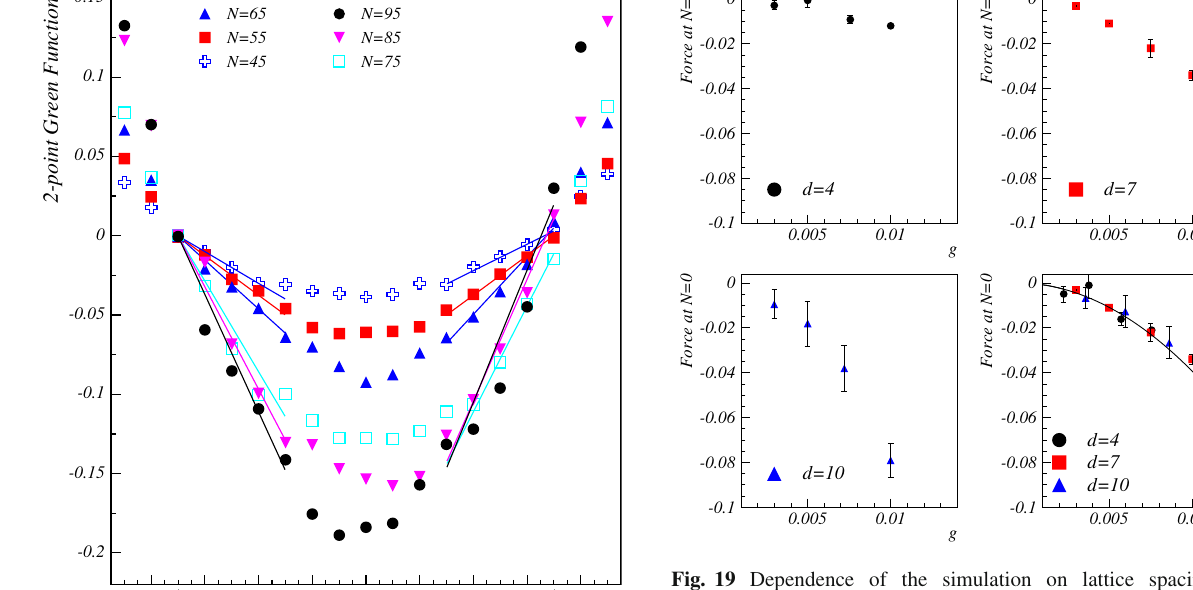
Fig. 19 Dependence of the simulation on lattice spacing. The Lagrangian of Eq. (12) is used. In the fo u r panels , the d ( G 2 p ( x ) − ( x ))/ d x part of the force along x is plotted as a function of G free − field 2 p the coupling g , in the classical N → 0 limit. The number of lattice nodes between the two matter terms is 2 d = 8 ( top left panel , circles ), 2 d = 14 ( top right panel , sq u ares ) and 2 d = 20 ( bottom left panel, tri- angles ). The bottom right plot shows these results for a same physical two-source system, after properly rescaling for the difference in phys- ical lattice units. The three calculations using different physical lattice units agree well. The f u ll c u rve is a second-order polynomial fit to